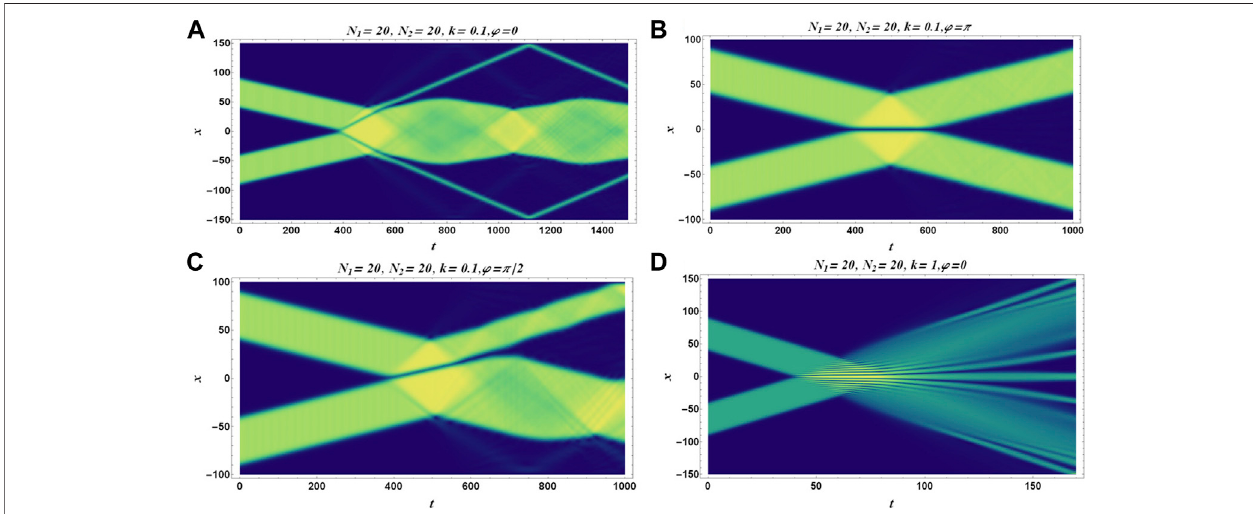
FIGURE 3 | (Color Online) Panels cover the time evolution of the droplets under collision between two droplets of the same particle numbers N 1 = N 2 = 20. Their respective momentum and phase are mentioned at the top of each panel.